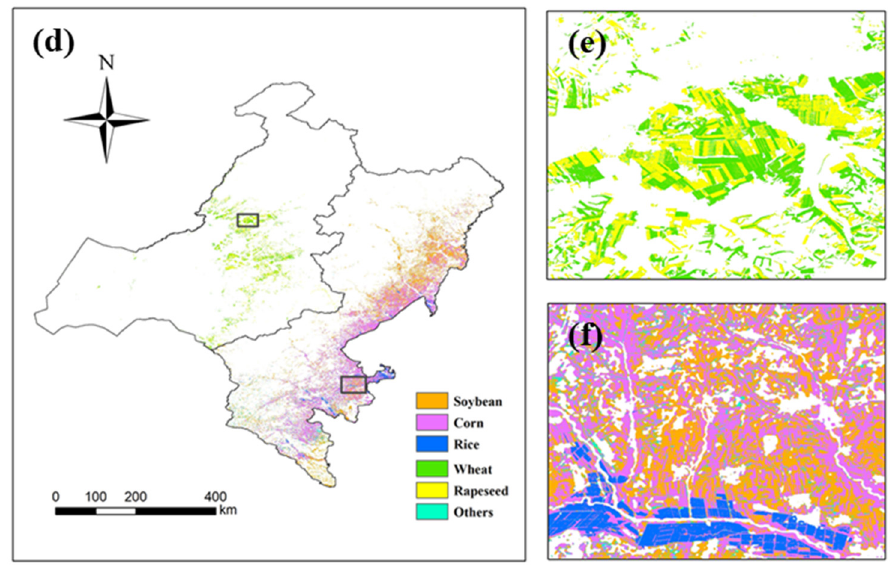
Figure 8. The crop type distributions of ( a ) 2017 and ( d ) 2018 over the study area; ( b , c ) are the close-up views of ( a ) for the AEZ A and B; ( e , f ) are the close-up views of ( d ) in the same regions of ( b , c ).